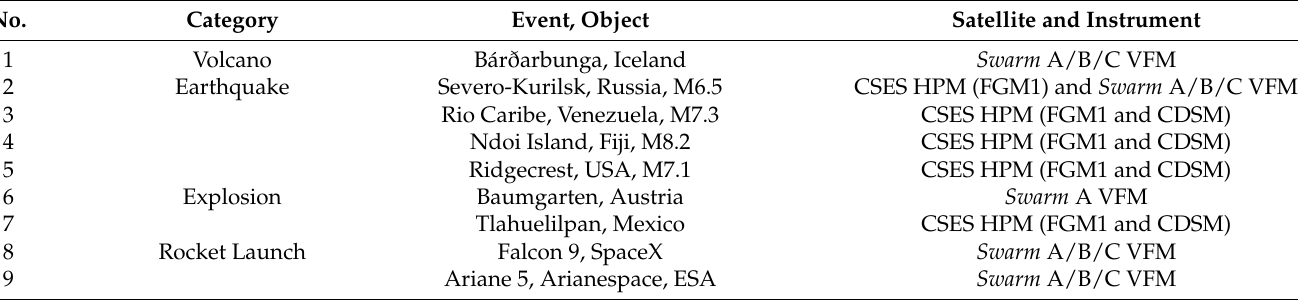
Table 1. Investigated lithospheric and (near) ground surface events with space based magnetic field measurements from CSES and Swarm satellites at LEO